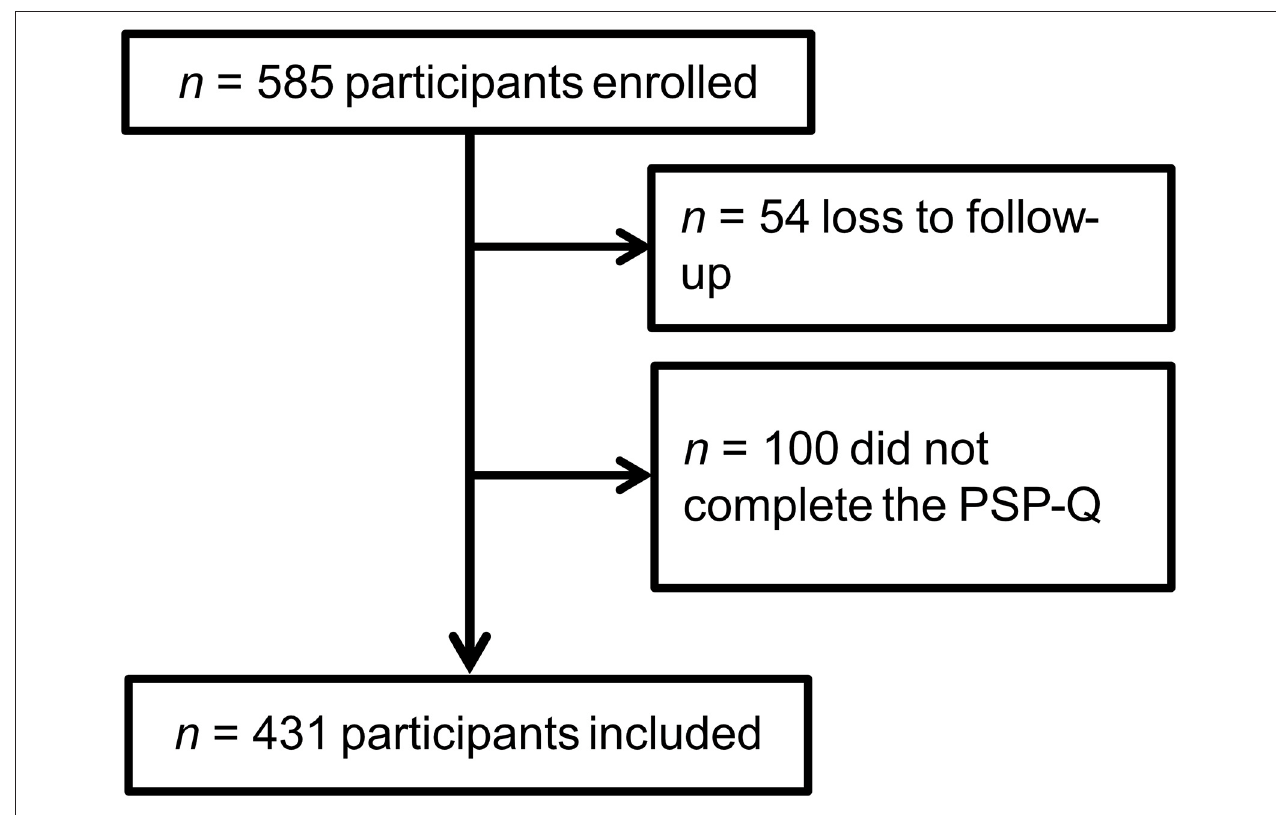
FIGURE 1 | Flowchart of participants included in the